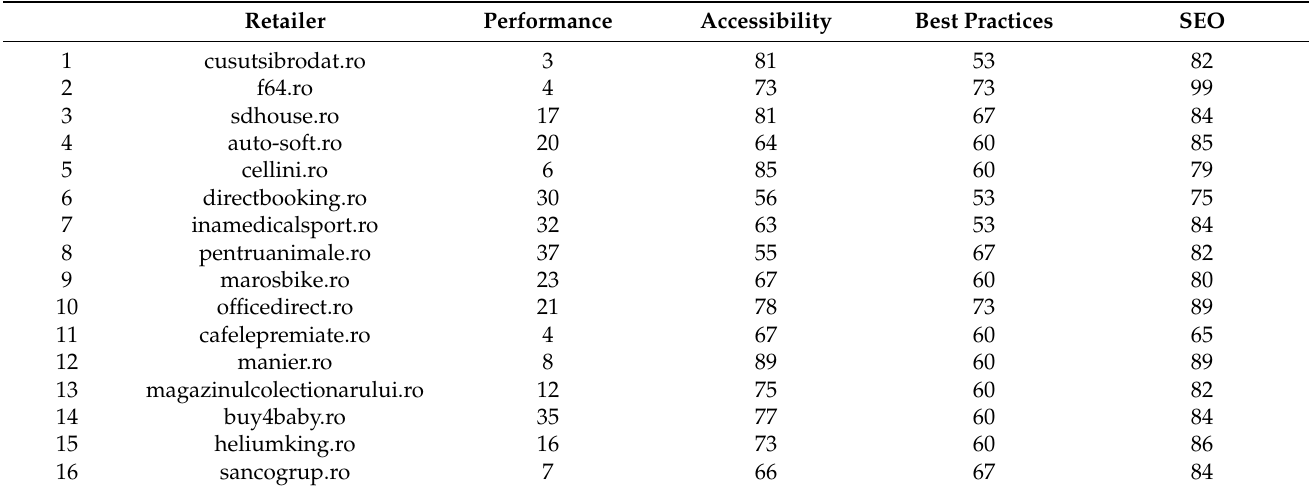
Table 6. The values of the indicators calculated by web.dev.